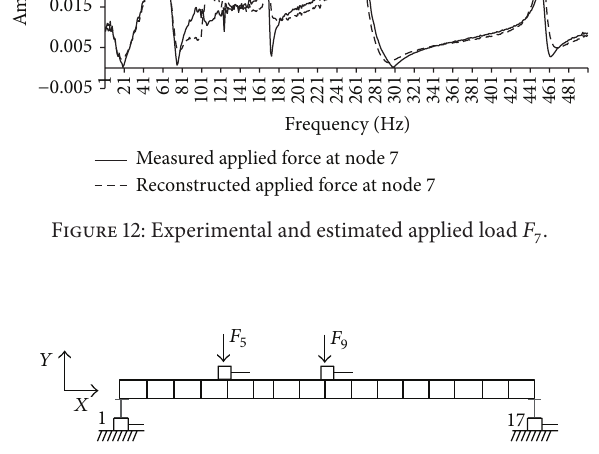
Figure 13: Illustration of the experimental setup for application 2.